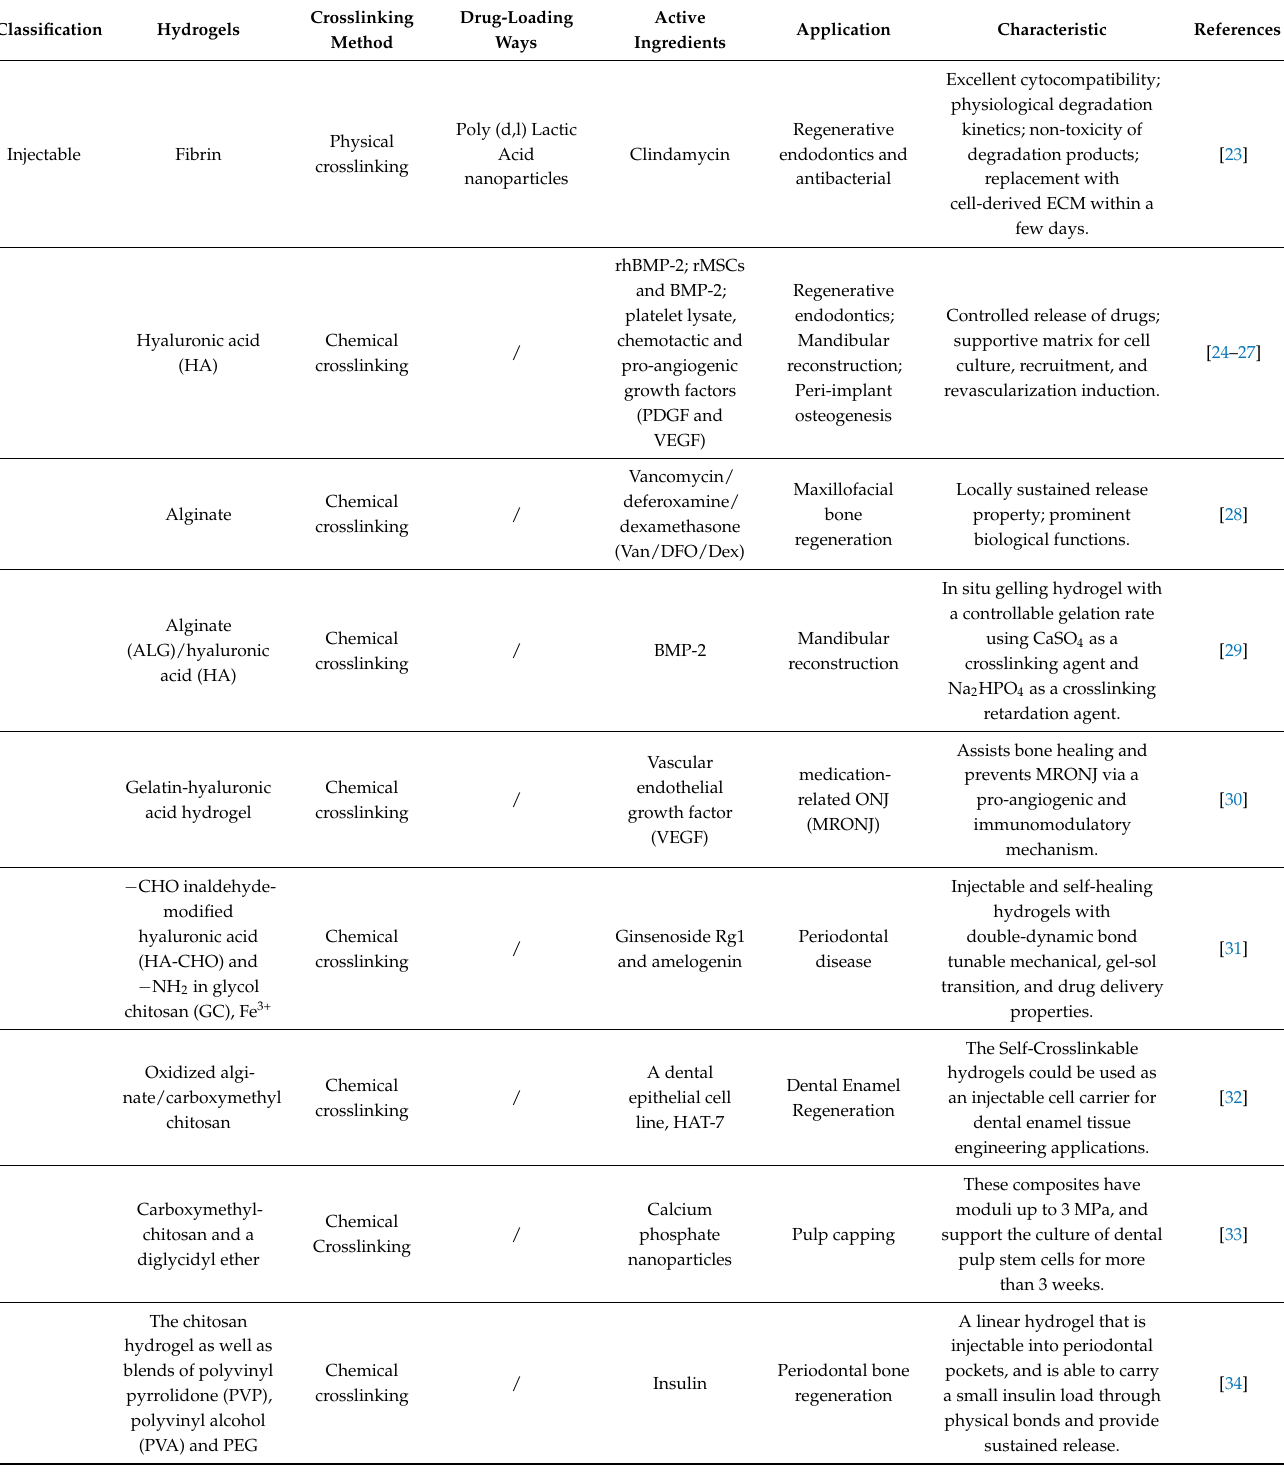
Table 1. The characteristics of the studies using hydrogels with special properties in this